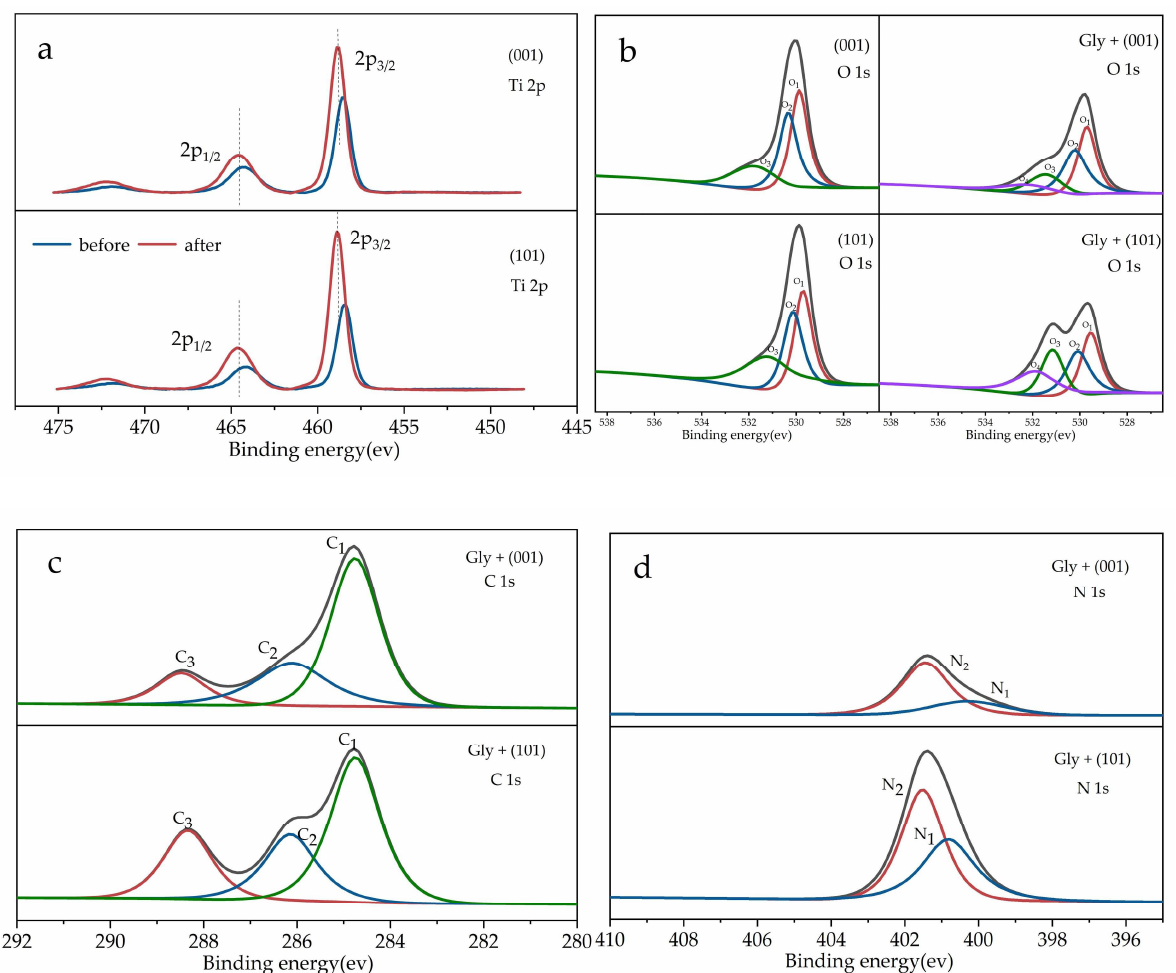
Figure 6. X-ray photoelectron spectrum curve. ( a ) XPS spectra of Ti atoms of two kinds of anatase (TiO 2 ) before and after the adsorption of glycine. ( b ) O 1s spectrum of two kinds of anatase (TiO 2 ) before and after the adsorption of glycine. ( c ) C 1s spectrum of two kinds of anatase (TiO 2 ) after the adsorption of glycine. ( d ): N 1s spectrum of two kinds of anatase (TiO 2 ) after the adsorption of